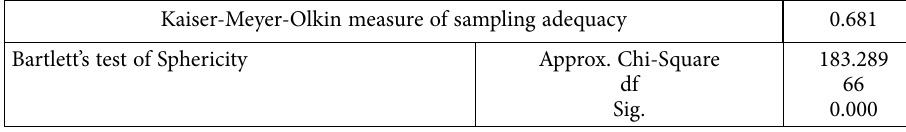
Table 3. SPSS  , Item Statistics and Item-Total